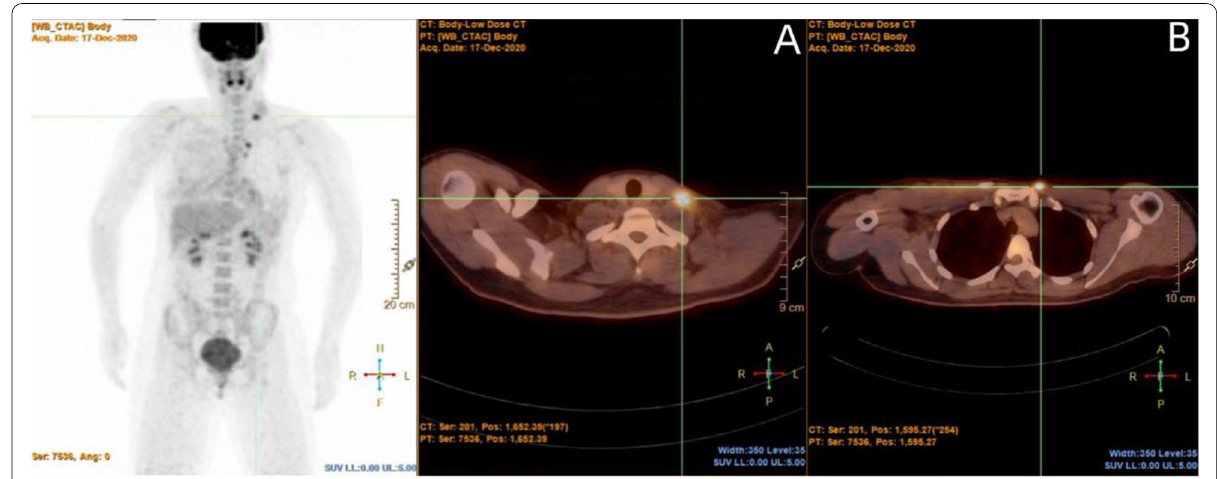
Fig. 1 Whole-body PET-CT: There were high metabolic lymph nodes in the left neck and high metabolic nodules on the left side of the sternum